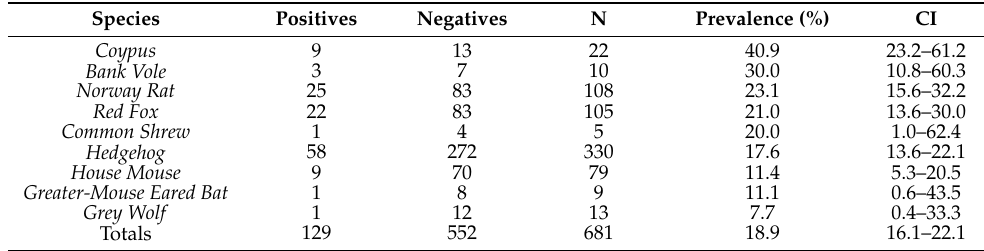
Table 2. Overall results of the animal population enrolled in the study, represented as number of positive and negative subjects, total number of animals enrolled for each species (N), the observed prevalence and the confidence interval of 95%